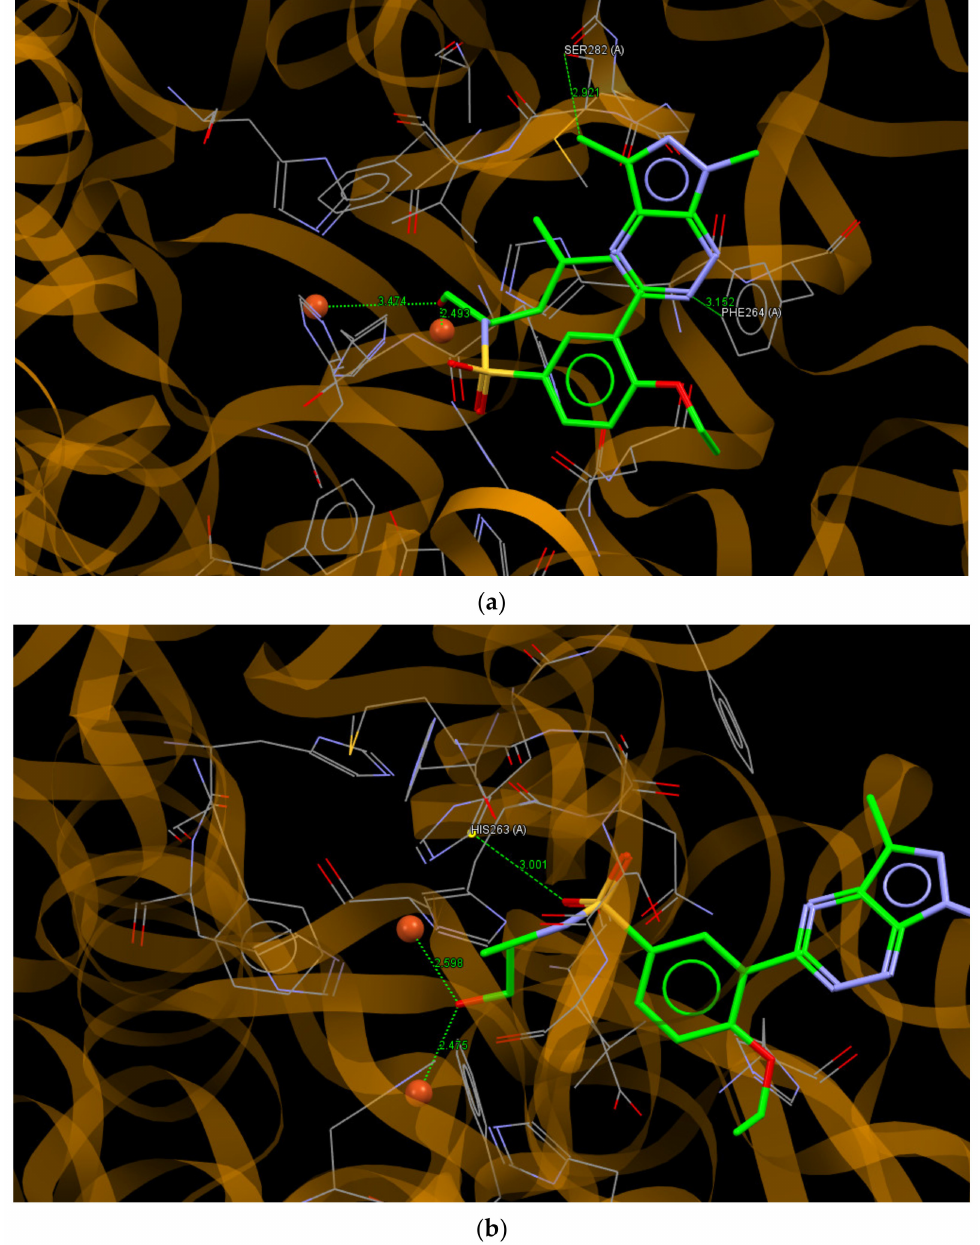
Figure 7. A view of the interaction of ( a ) 8j and ( b ) 8b with amino acids of the binding site in mushroom